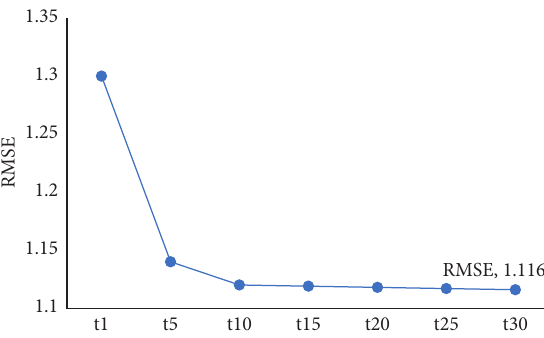
Figure 17: Performance of the number of iterations on Yelp. Table 3: Evaluation of the running